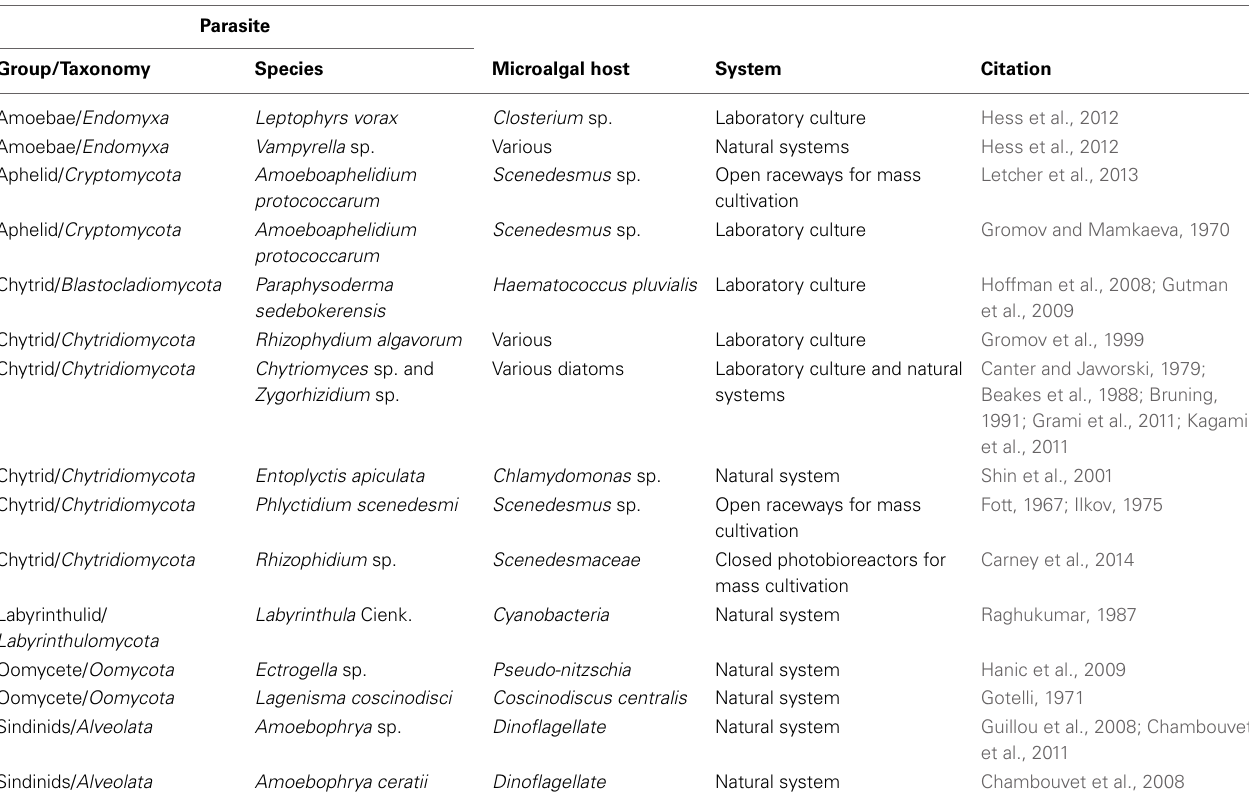
Table 1 | Parasites reported for microalgae, including common group names and phyla, and the type of system the relationship was reported